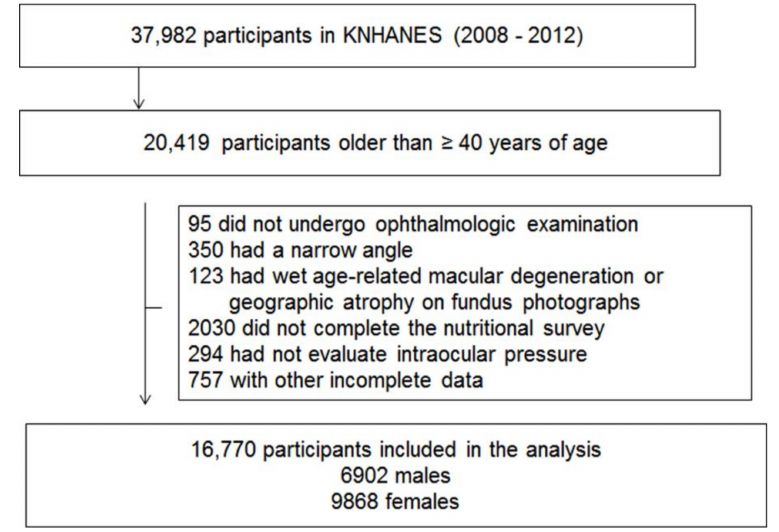
Figure 1. Flow diagram displaying selection of study subjects.